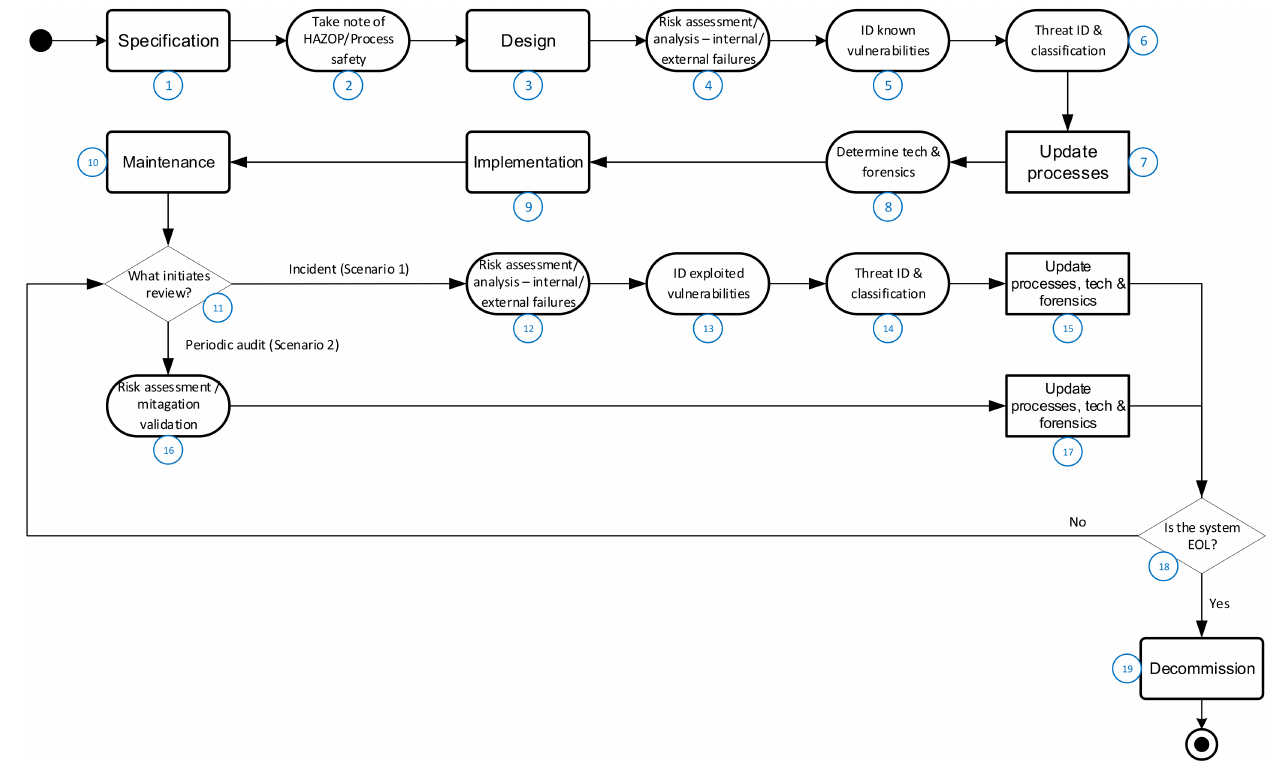
Figure 13. Harmonized taxonomy and generic methodology.